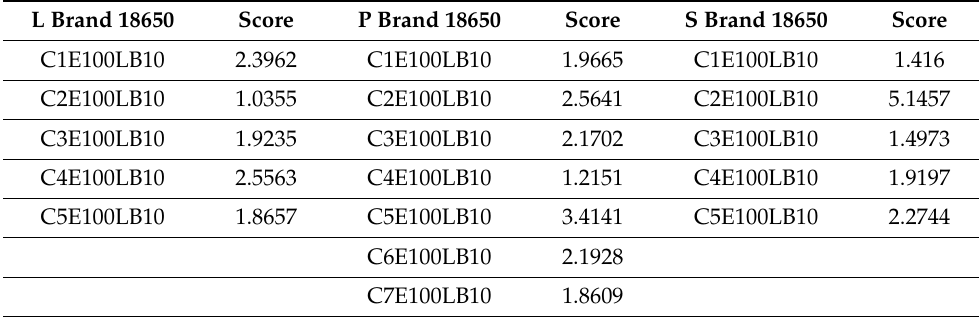
Table 2. Results of MLP, Epoch = 100, look_back = 10.